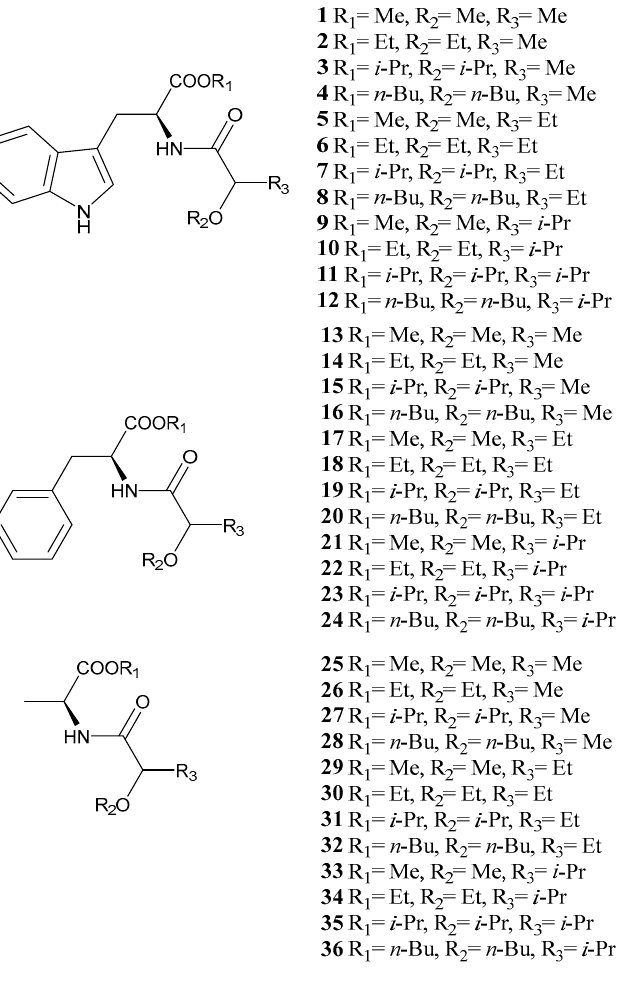
Figure 2. General molecular structure with substituents of the 36 molecules evaluated by quantum mechanics and molecular docking calculations.